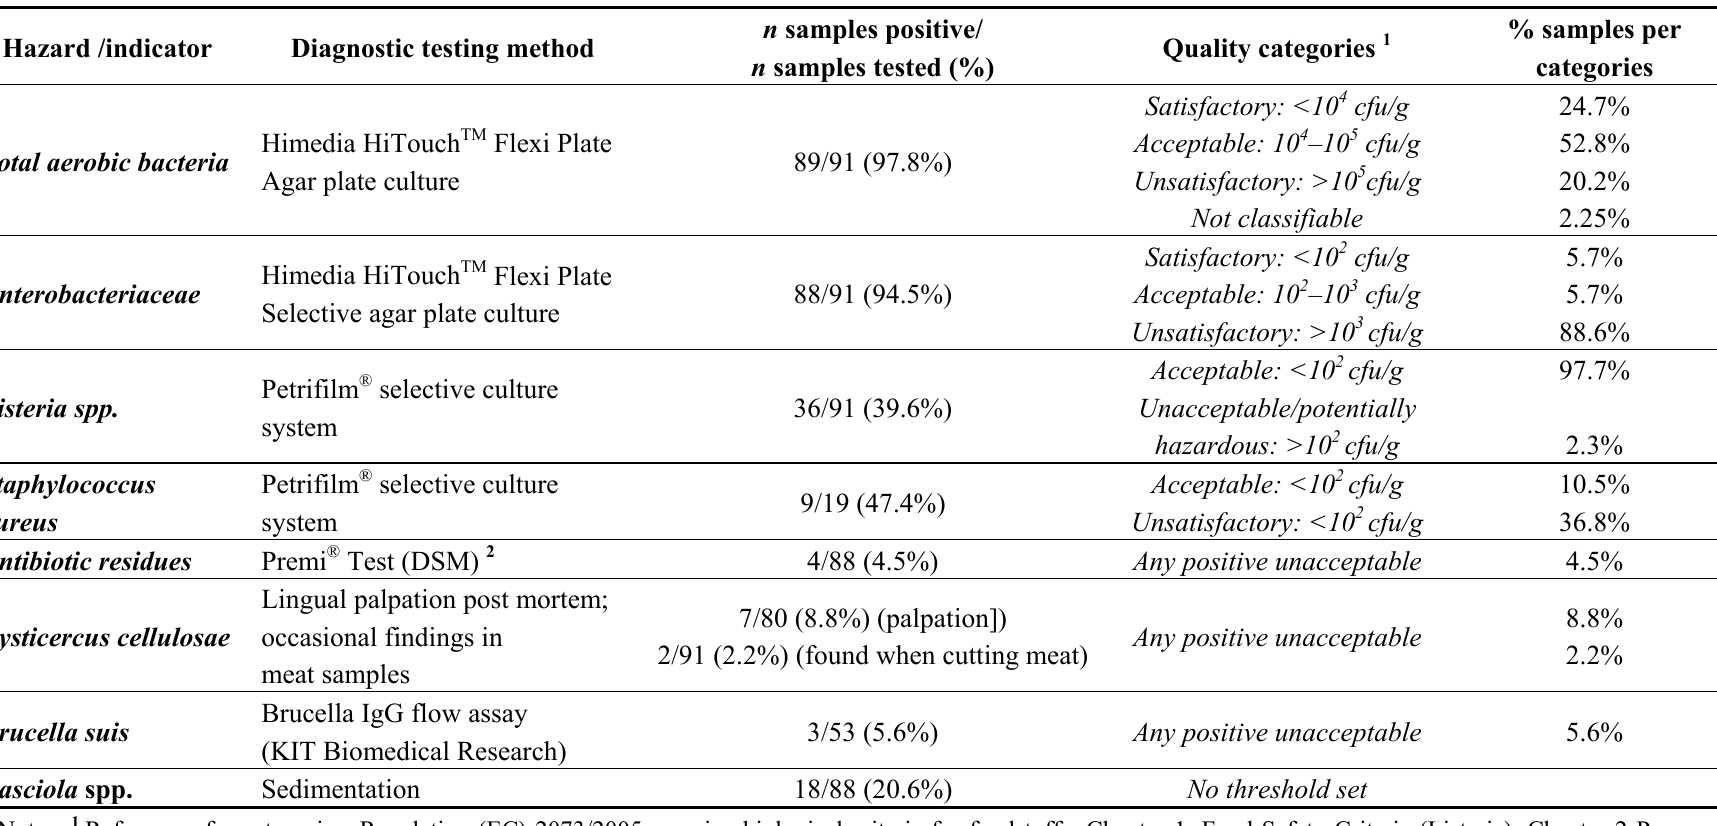
Table 1. Outcomes of diagnostic testing of slaughter pigs and retail pork carried from Kohima, Nagaland: Hazards and classification based on reference